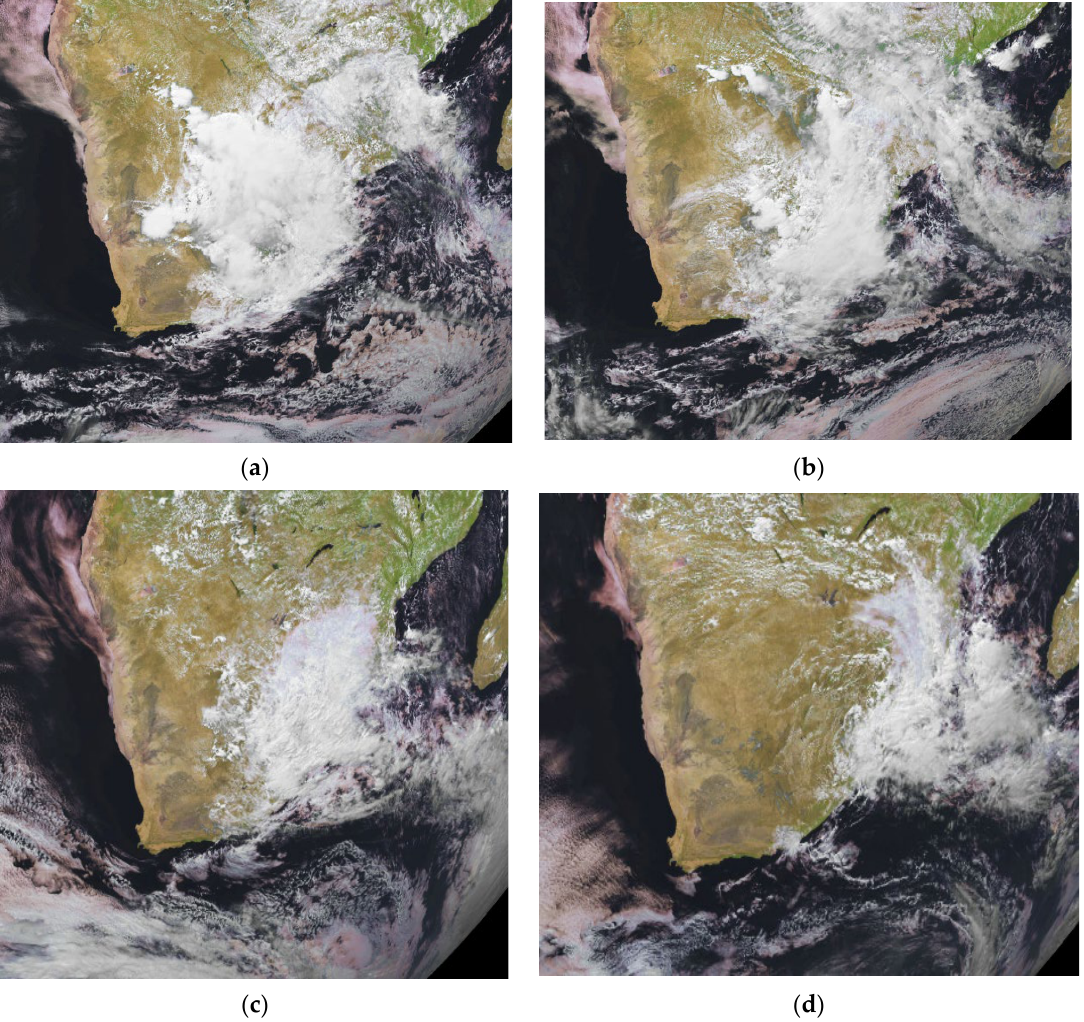
Figure 3. EUMETSAT daily composite satellite images over southern Africa during the 9th ( a ), 10th ( b ), 17th ( c ), and 18th ( d ) of April 2022.